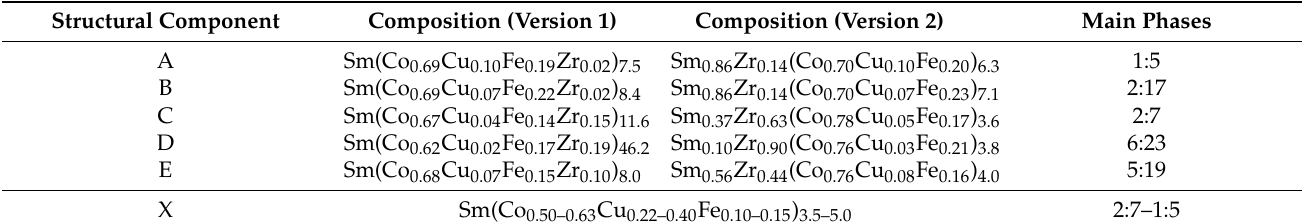
Table 2. Averaged chemical compositions of structural components A and B and phases C, D, and E and structural component X, which are present only within component